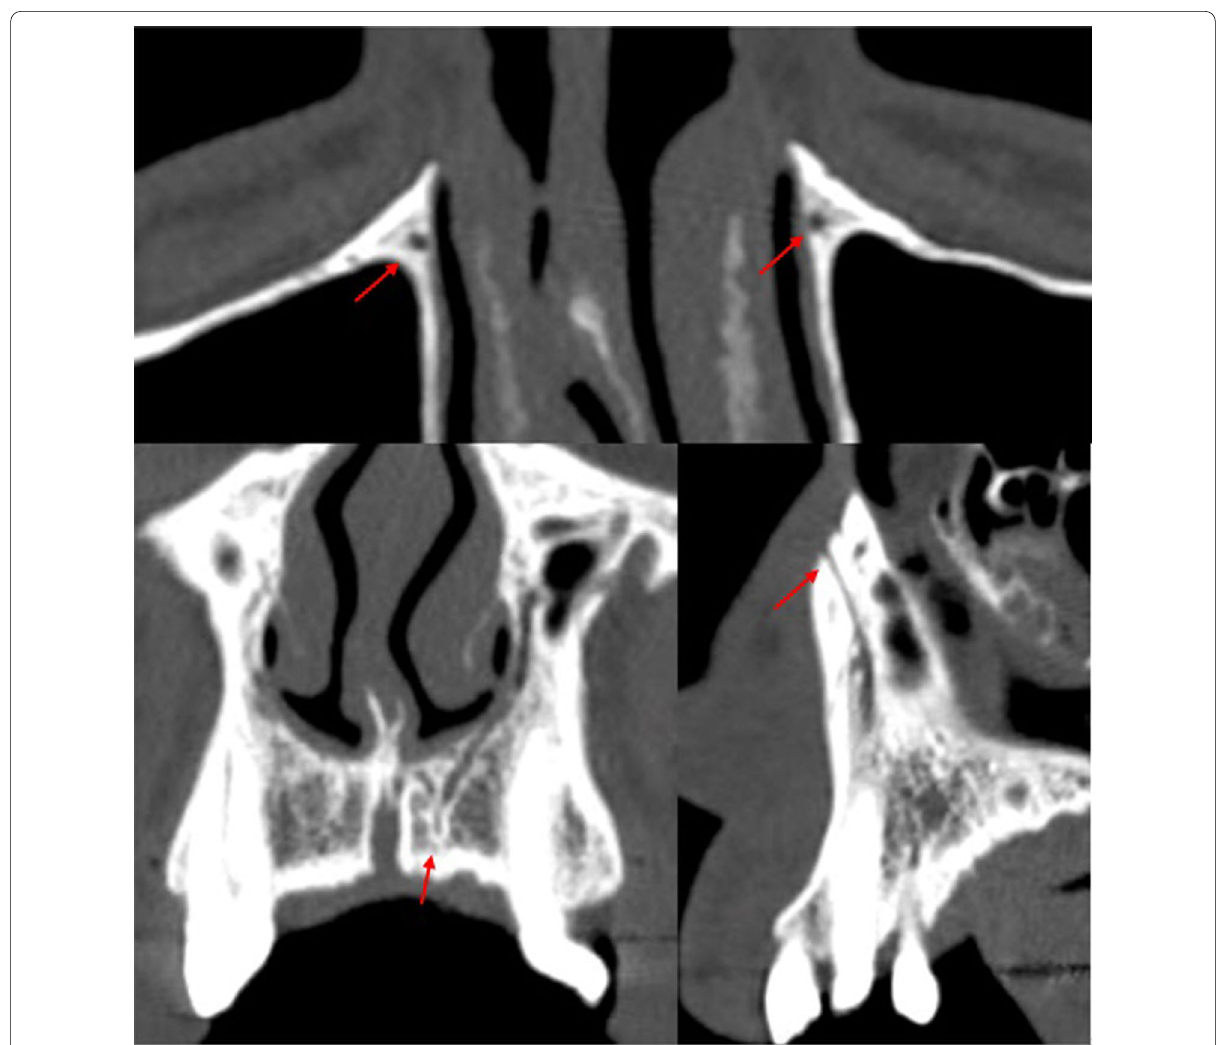
Fig. 3 CS branches course from the infraorbitary canal to the hard palate in the maxilla seen in different planes (axial, frontal,